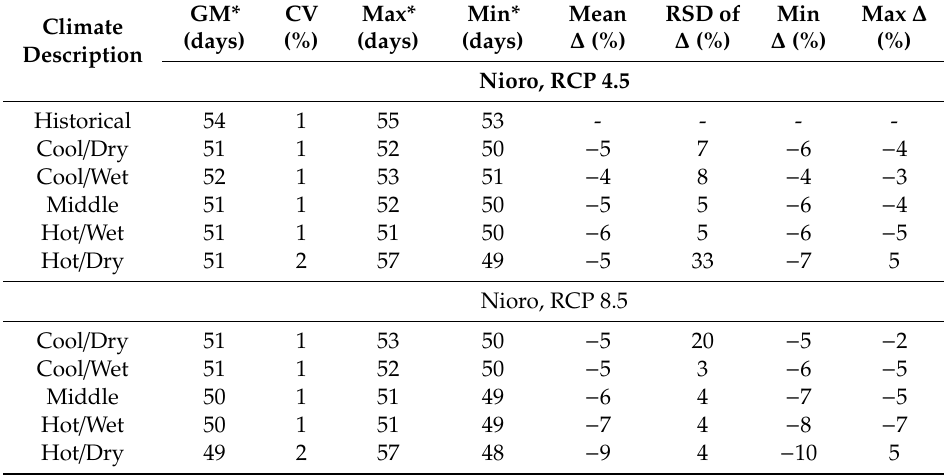
Table A1. Imparct of climate change scenarios on days to flowering at three sites in semi-arid region of West